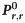
Detection rates against Pr,r0 for count communication data with |V| = 50 and two communities.P1,1′=(1+0.5)×P1,10.